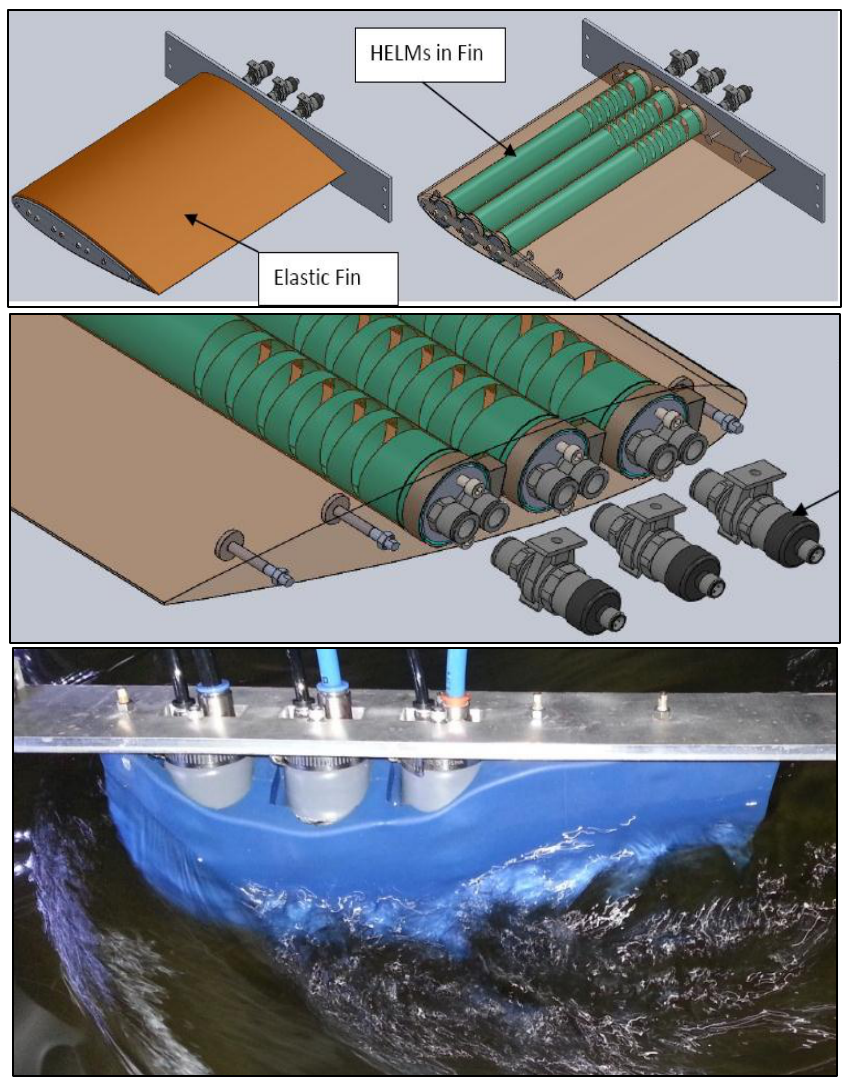
Figure 12. Prototype for underwater propulsion mechanism powered by three HELMs embedded in a silicon fin.